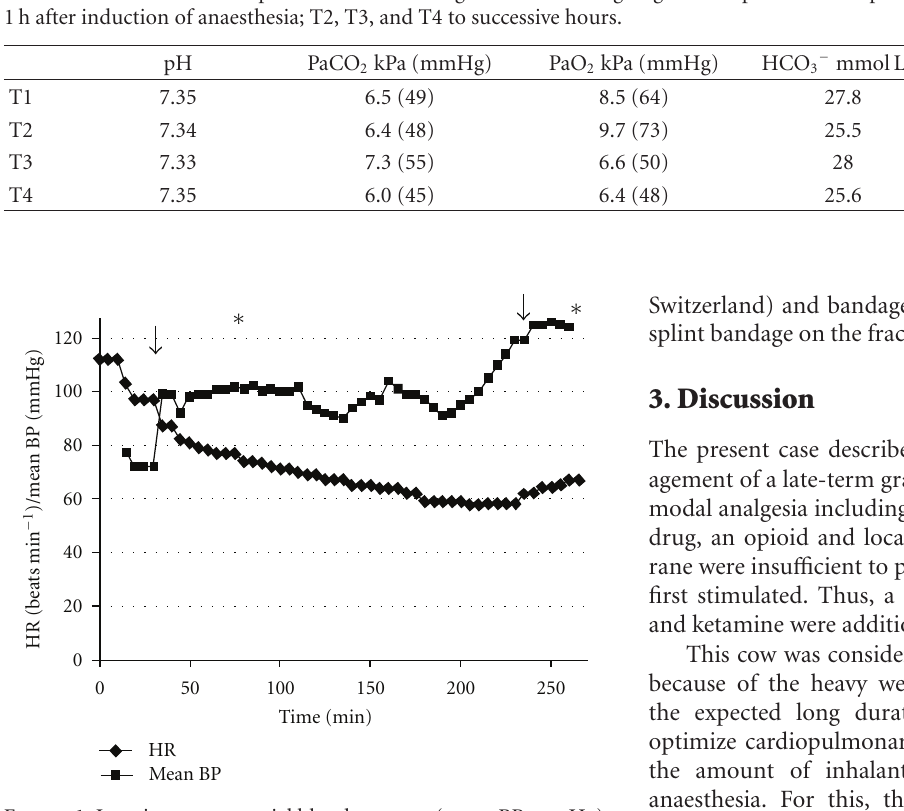
Figure 1: Invasive mean arterial blood pressure (mean BP, mmHg) and heart rate (HR, beats min − 1 ) during maintenance of anaesthe- sia of a gravid cow undergoing metacarpal fracture repair. Arrows correspond to the beginning and end of the constant rate infusion of ketamine (0.6 mgkg − 1 h − 1 ) and xylazine (0.02 mgkg − 1 h − 1 ). Aster- isk ( ∗ ) corresponds to the beginning and the end of the